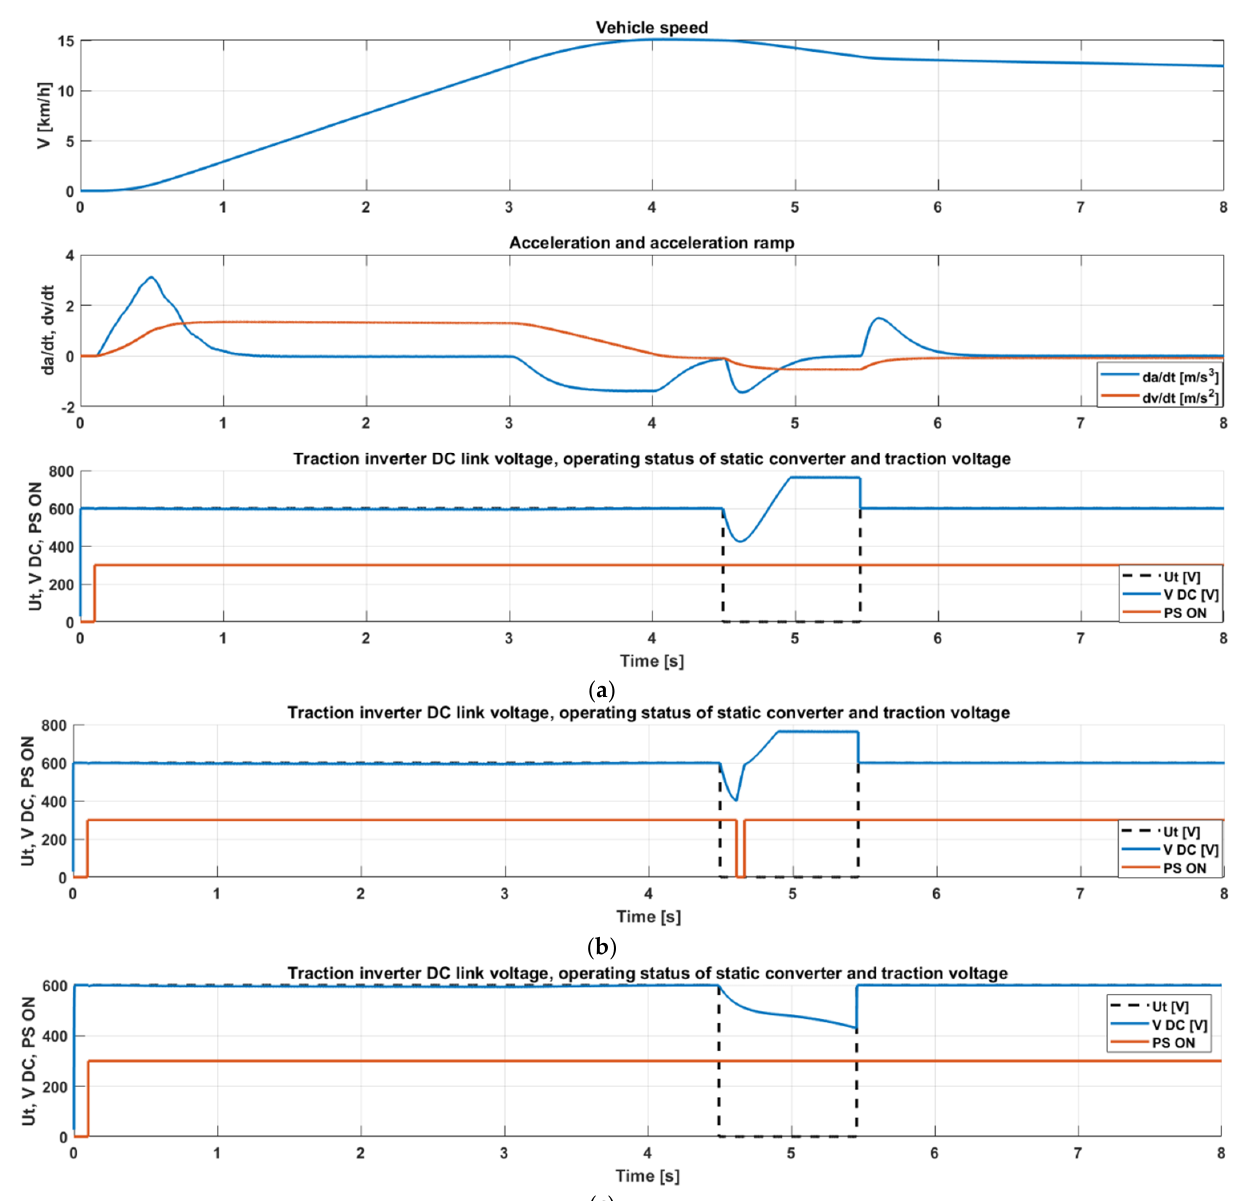
Figure 10. Simulation results for an initial speed of 15 km/h and loads of ( a ) 17 kW C d = 10 mF, ( b ) 18 kW C d = 10 mF, ( c ) 28 kW C d = 50 mF.